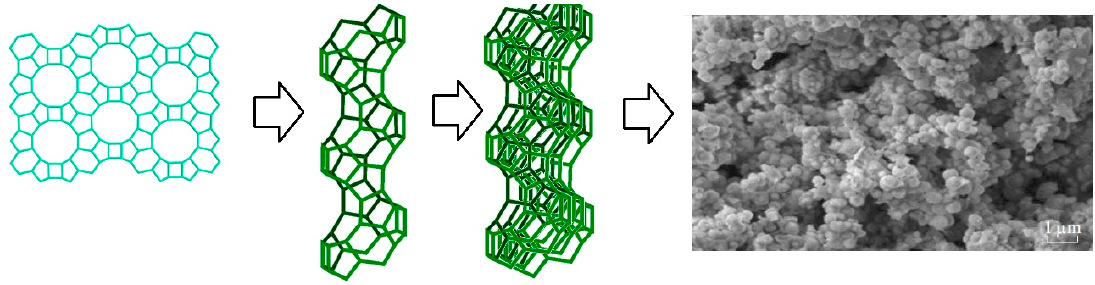
Figure 16. Design for zeolite synthesis type BETA [compiled by the authors].